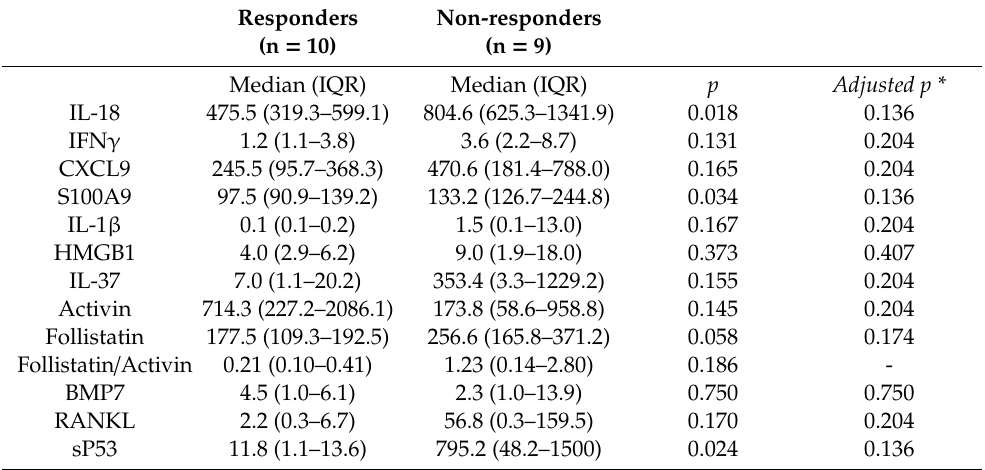
Table 2. Median baseline serum cytokines levels [pg / mL] in responding versus non-responding